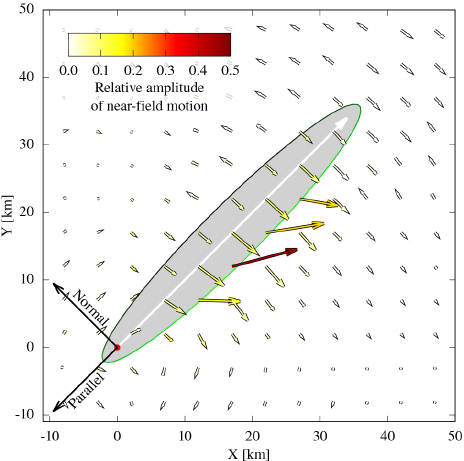
Figure 13. Orientation of horizontal peak ground acceleration for the simulated waveforms. The arrow length scales with magnitude of acceleration. The simulated rupture plane is oriented as the rup- ture plane of the Kumamoto earthquake (strike: 225 ◦ , dip: 70 ◦ ) and of elliptic shape (grey). The upper side is denoted by the green line, and the lower half is denoted by black. The rupture process origi- nated at the hypocentre (red dot) with circular propagation outwards (white arrow).